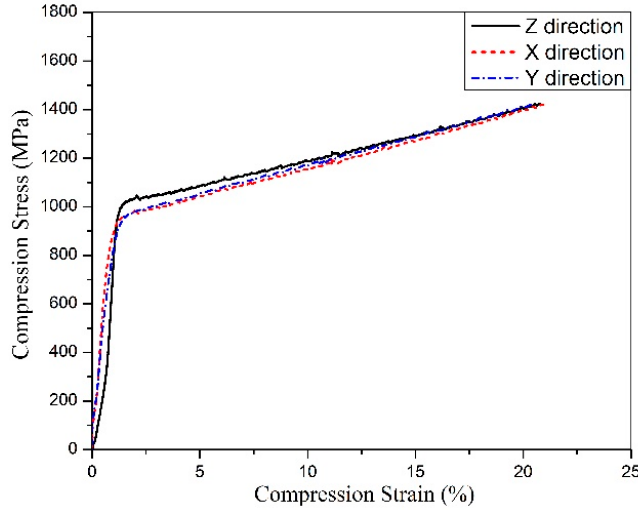
Figure 8. Stress–strain curves of the β -Ti21S produced by L-PBF under compression loading along the z-direction.